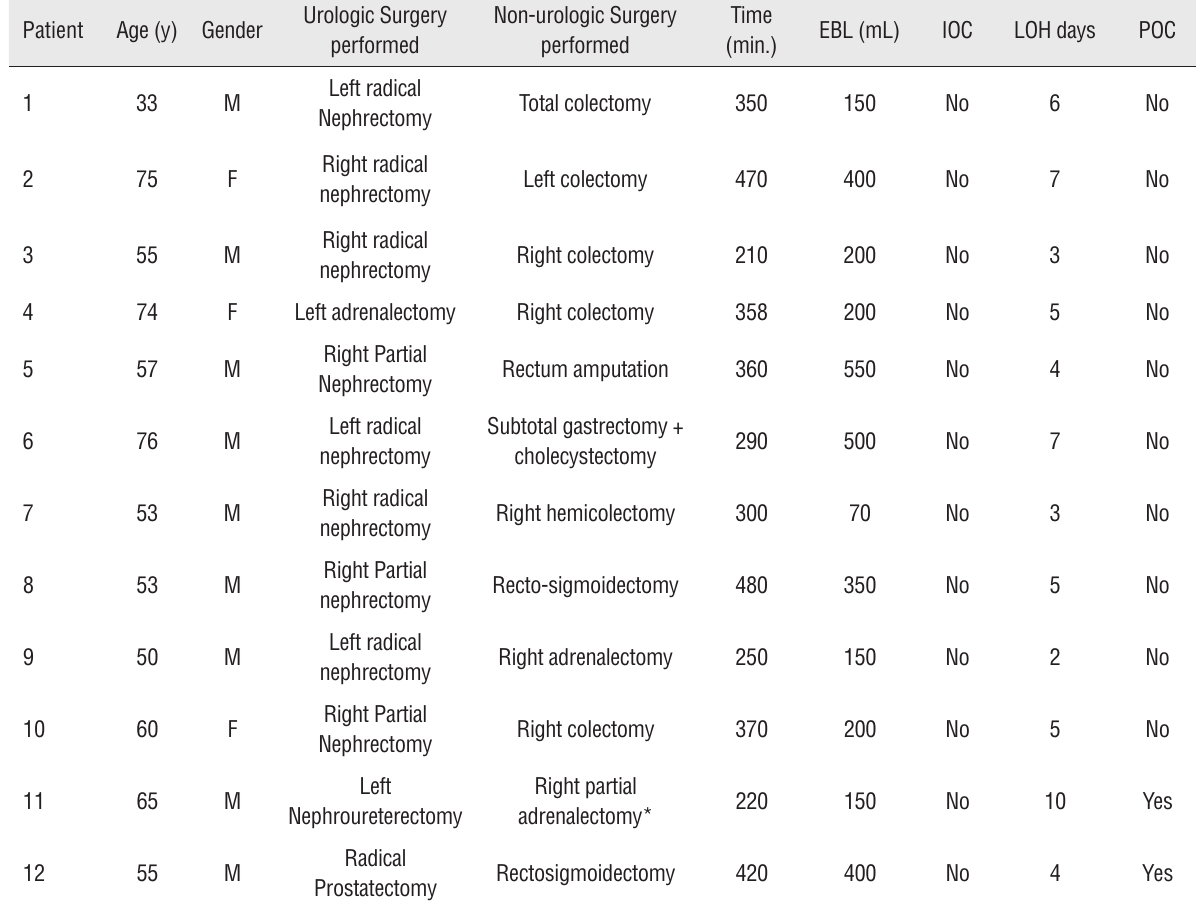
Table 2 - Demographic caractheristics, intraoperative data and complications.